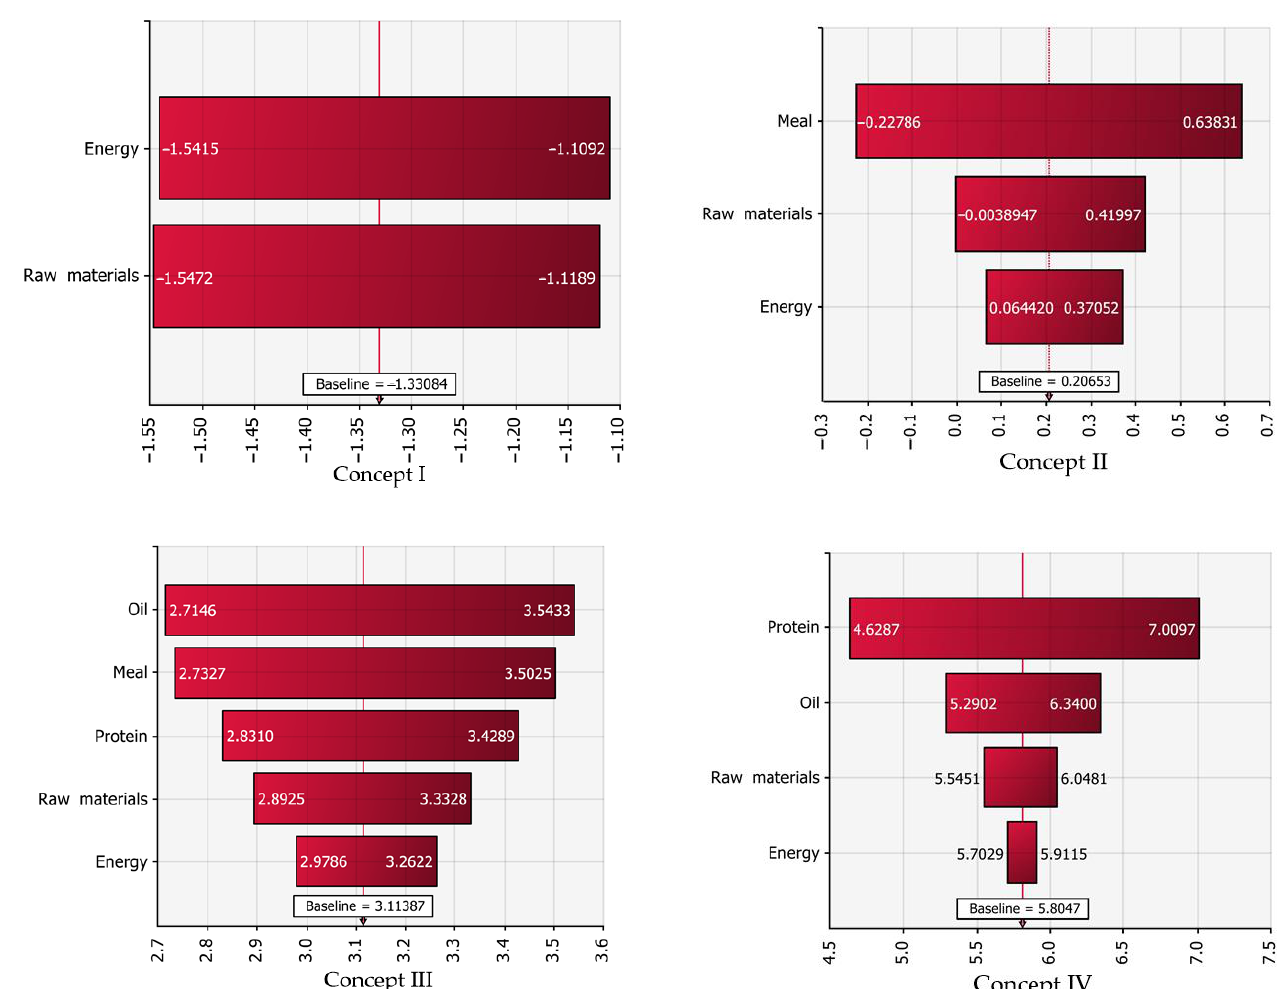
Figure 8. Sensitivity analysis of profitability. Four different fish co-stream processing technologies presented here. Baseline refers to annual profit.